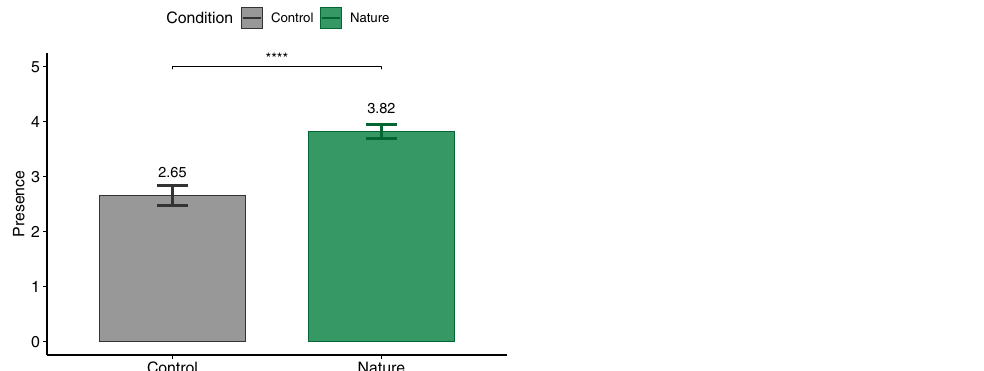
Figure 8. Igroup presence questionnaire (IPQ).